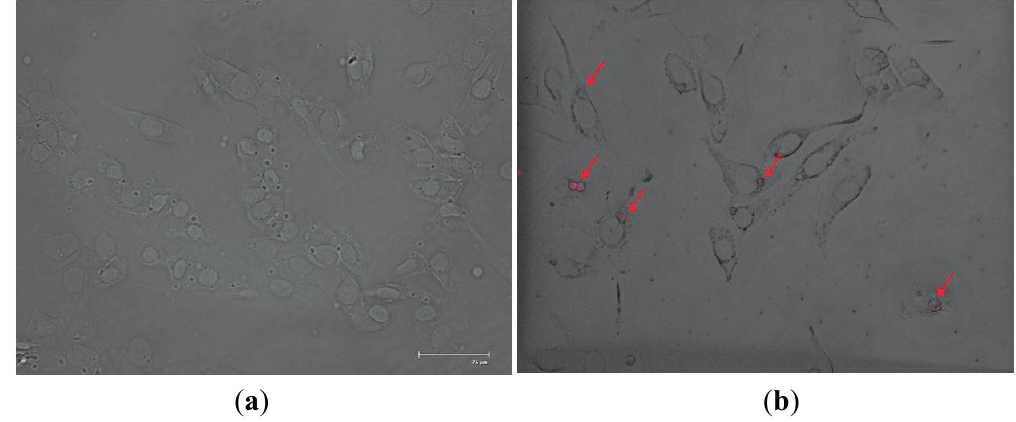
Figure 1. The live fluorescent images of silk fibroin modified chitosan nanoparticles (SF-CSNPs) (red) taken by HepG2 cells. ( a ) cells without SF-CSNPs; ( b ) cells with SF-CSNPs at a concentration of 5 μ g/mL for 12 h at 37 °C, the red fluorescence was localized near the cell nuclei. Images represent merged images of differential interference contrast (DIC) and red fluorescence. (600×, scale bar: 75 μ